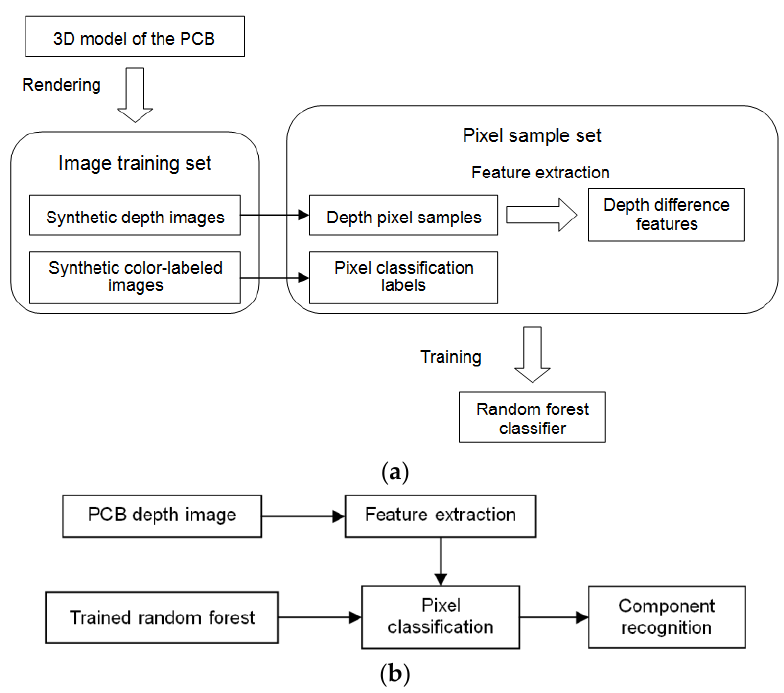
Figure 1. The framework of the proposed method. ( a ) Training. ( b ) Testing.